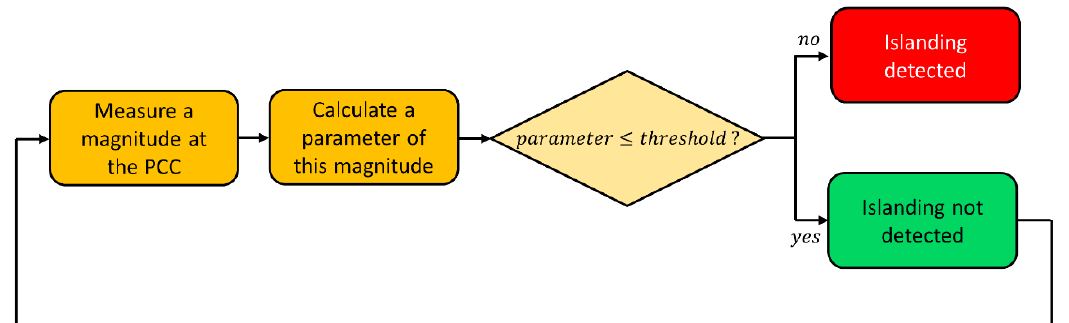
Figure 2. General scheme of passive methods.